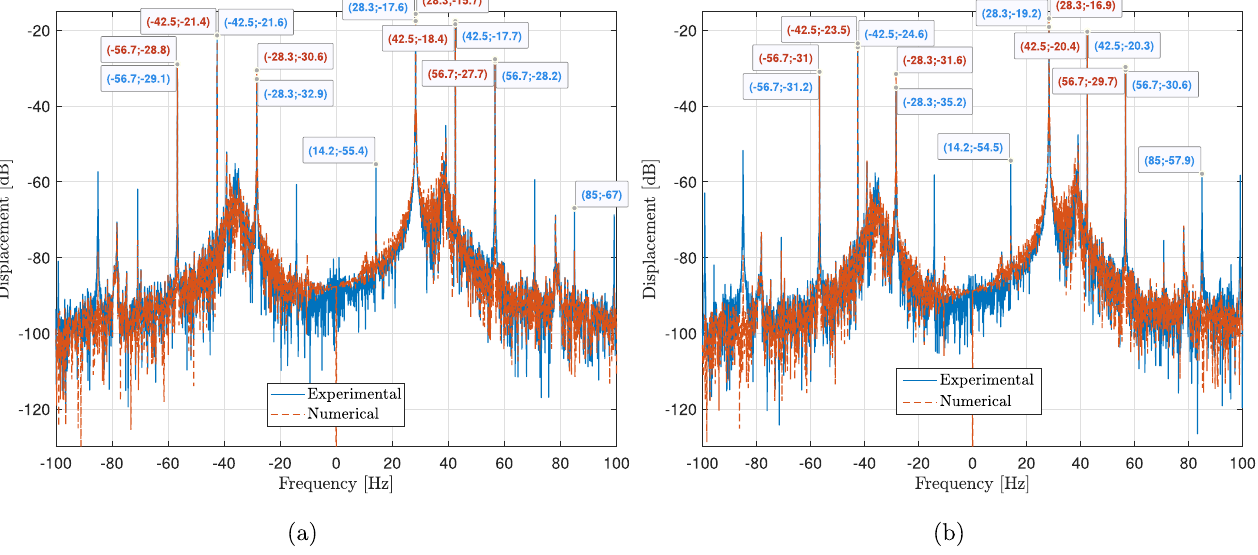
Fig. 6. Full spectrum of the numerical and experimental orbits of Figure 5: (a) Node 15 and (b) Node